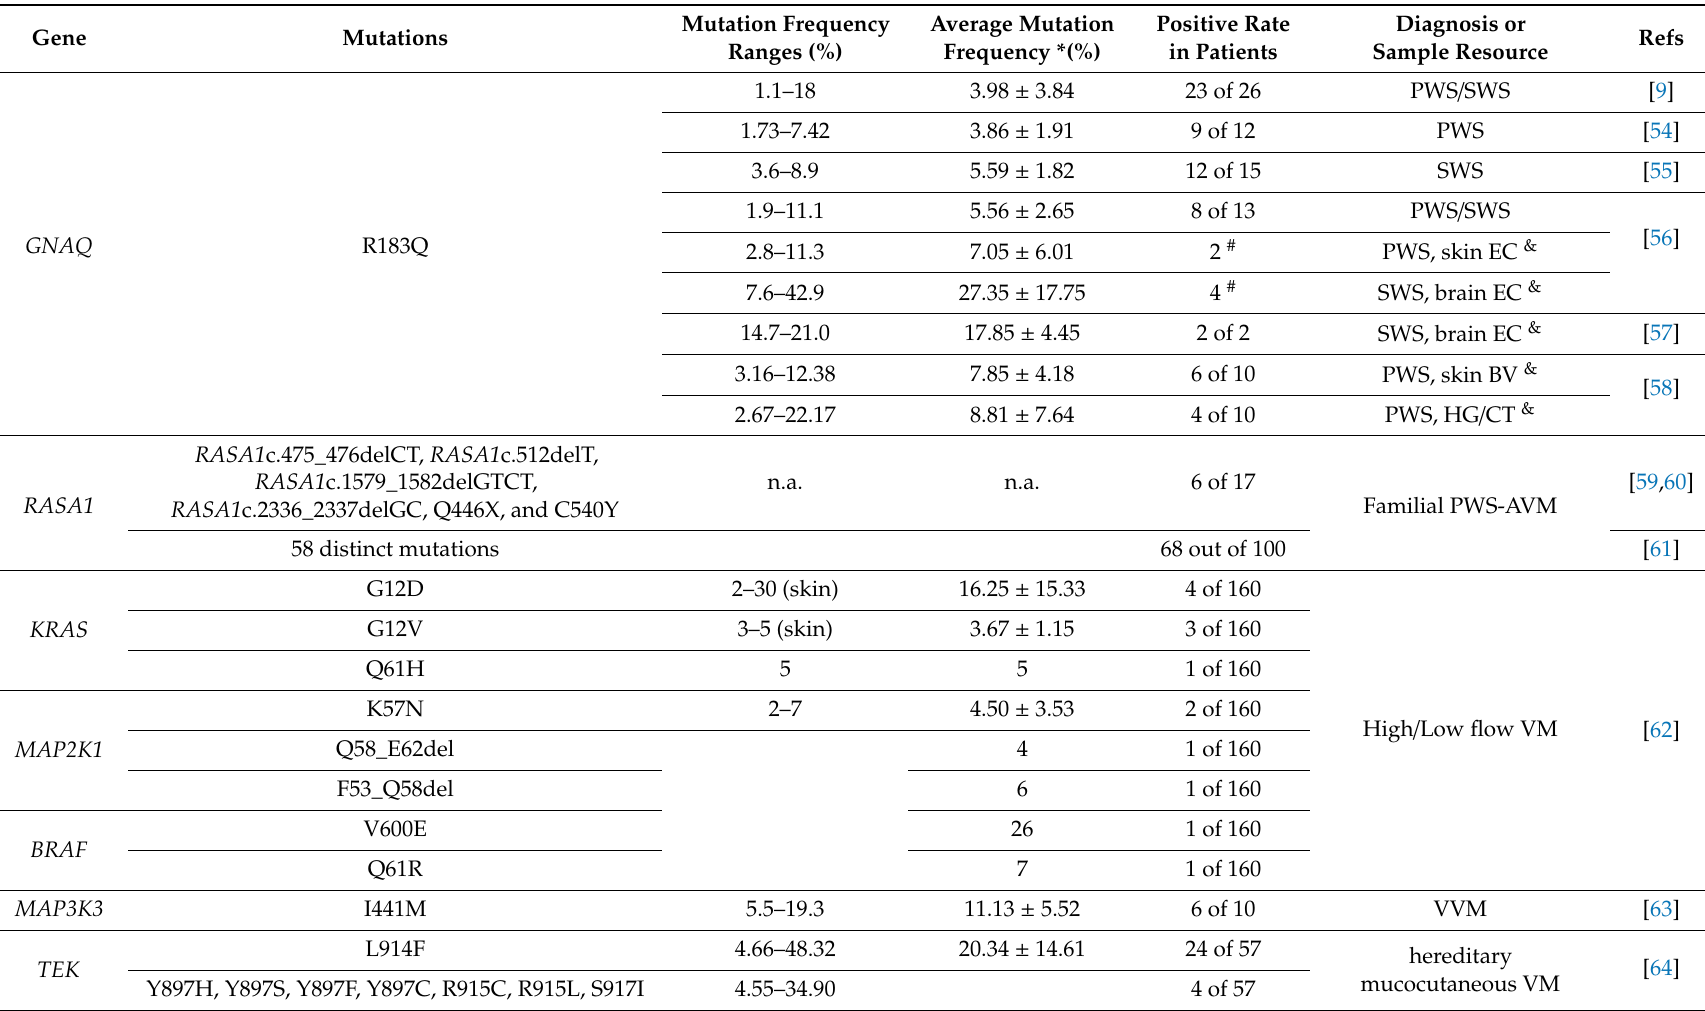
Table 1. Mutations involving PWS / SWS or associated vascular